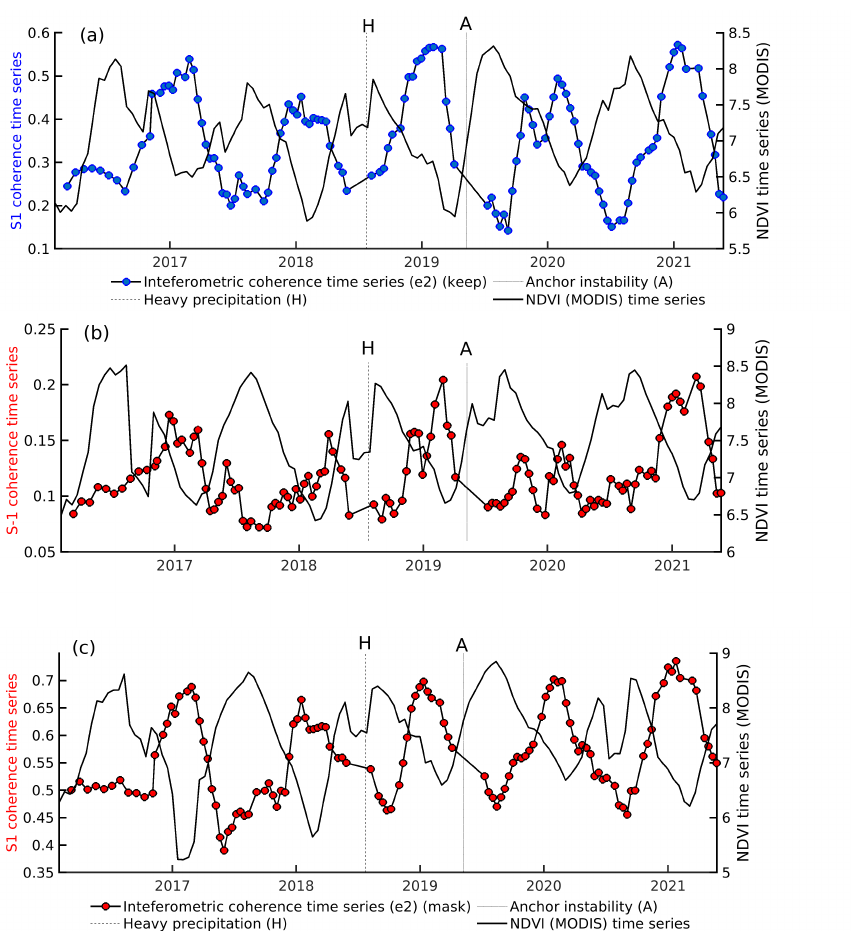
Figure 10. The inversely linear correlation relation between the S-1 interferometric coherence and MODIS NDVI time series. ( a ) An example of a pixel to be excluded from an RF mask, as it may be related to ground motion (S-1 interferometric coherence values decrease with the decline in the MODIS NDVI curve). ( b , c ) Example of pixels to be masked